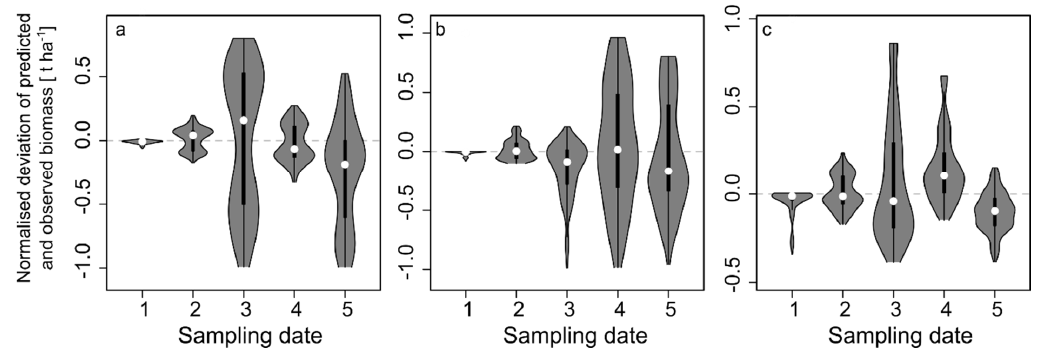
Figure 6. Normalized deviations of the predicted from the observed values for ( a ) eggplant, ( b ) tomato, and ( c ) cabbage for each sampling date. The dotted line indicates zero deviation and thus perfect fit between measured and predicted biomass values. The areas around the lines indicate the probability density of the data.